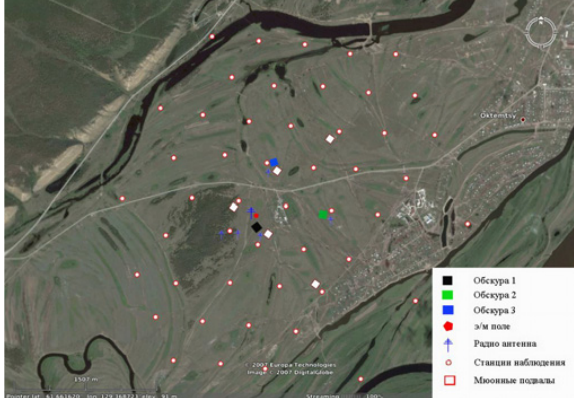
Figure 2. The Yakutsk Extensive Air Shower array scheme. a possibility to locate the position of the maximum on the anode surface.